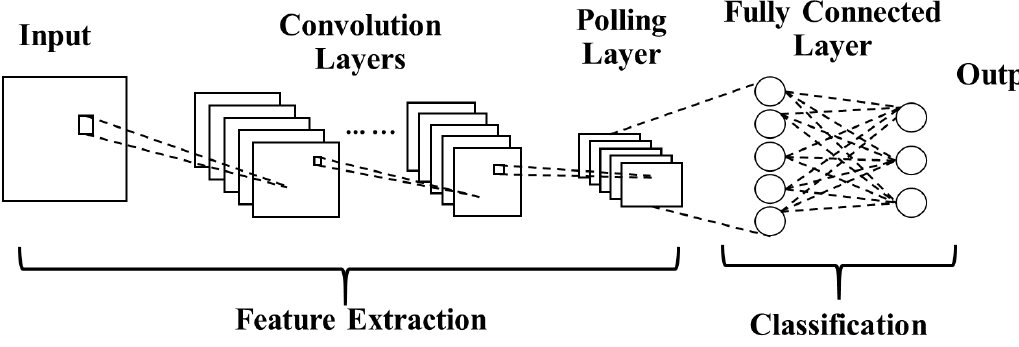
Figure A2. Fundamental Structure of a CNN.